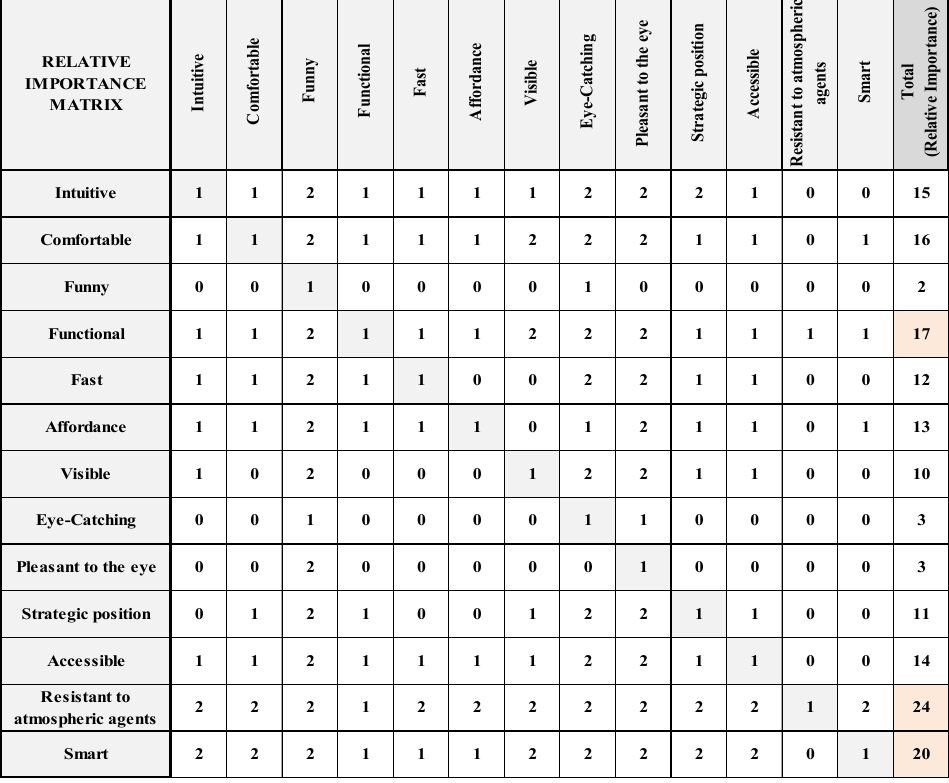
Figure 4. Relative Importance Matrix. The machine counts how many cigarette butts are introduced through an optical system.